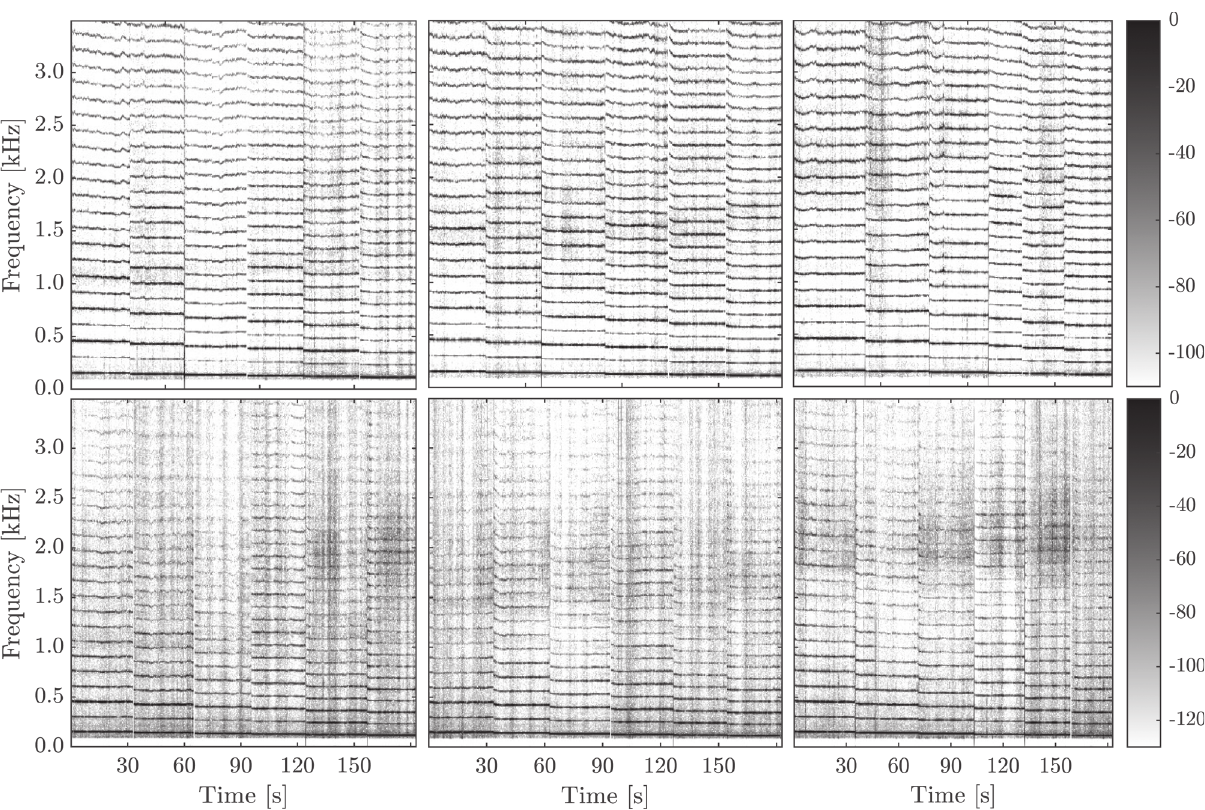
Figure 3. Spectrograms of six notes played in a descending scale using a clarinet mouthpiece. Top panels at forte and bottom panels at piano playing levels for resonators with, from left to right, f c = 1.0, 1.5, 2.0 kHz. The analysis is performed on composite signals from the Neumann U87 and two Neumann KM 184. Color map in